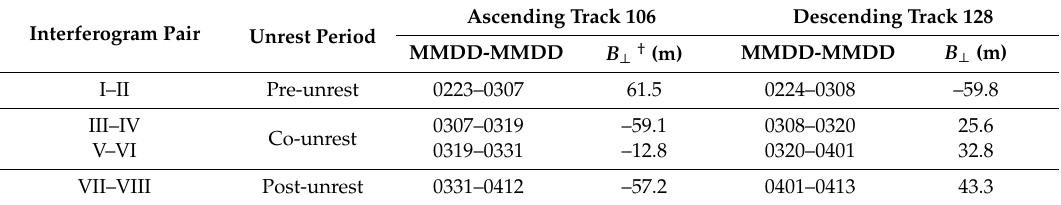
Table 1. Interferogram sequence and the distinction of unrest